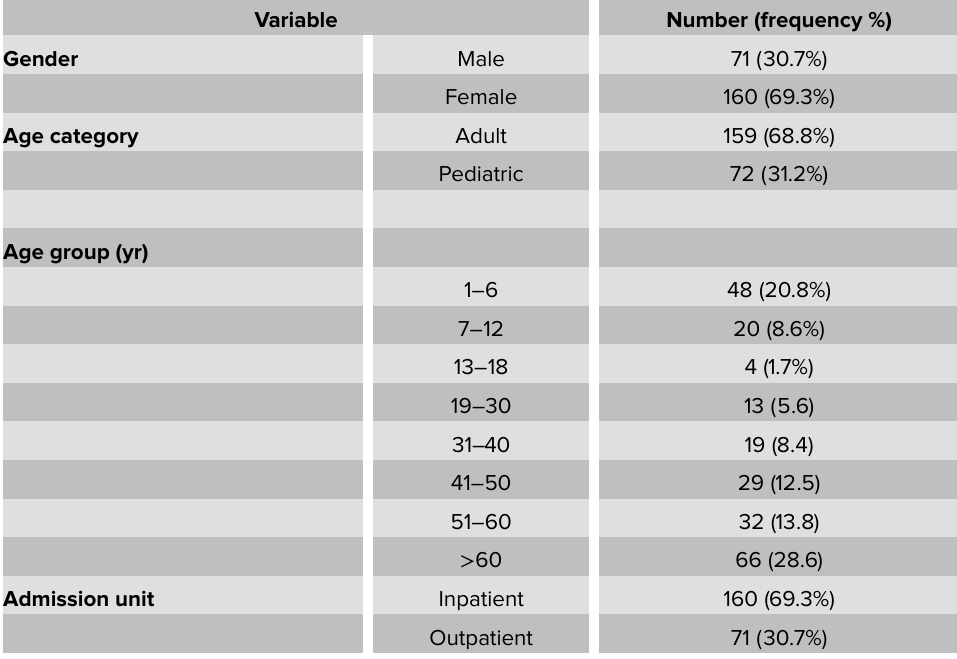
Figure 1 : Distribution of study sample according to multiple antibiotics resistance. Table 1: Demographic characteristics of the participants ( n =